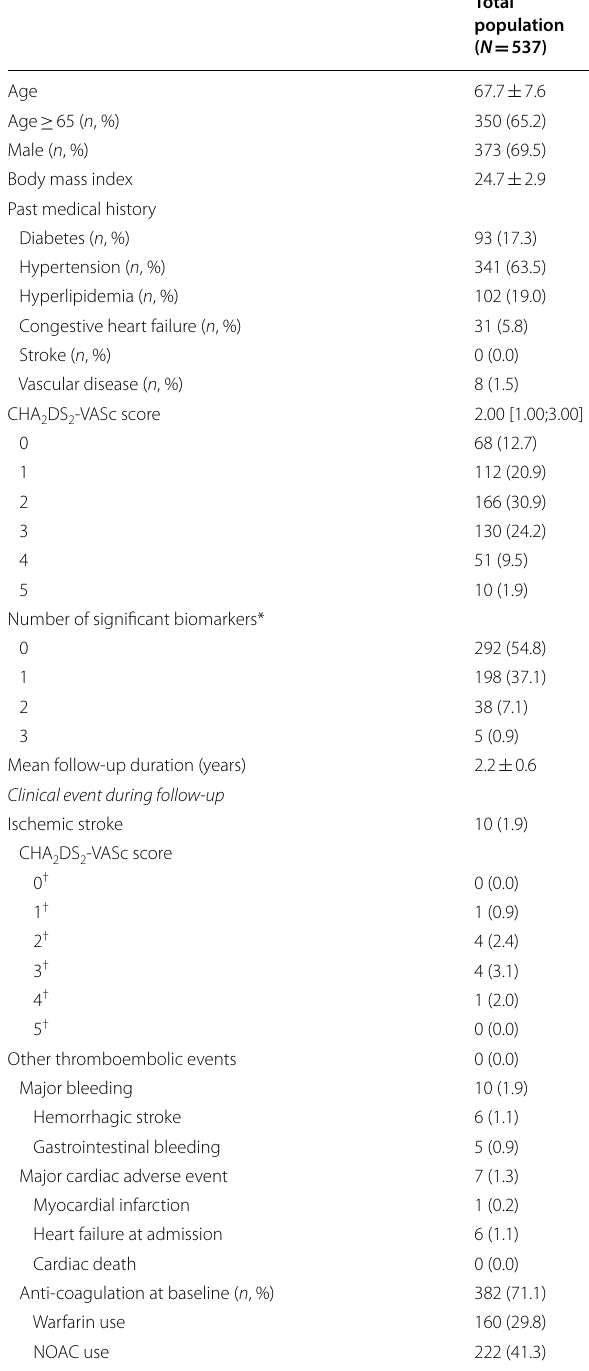
Table 1 Baseline characteristics of study